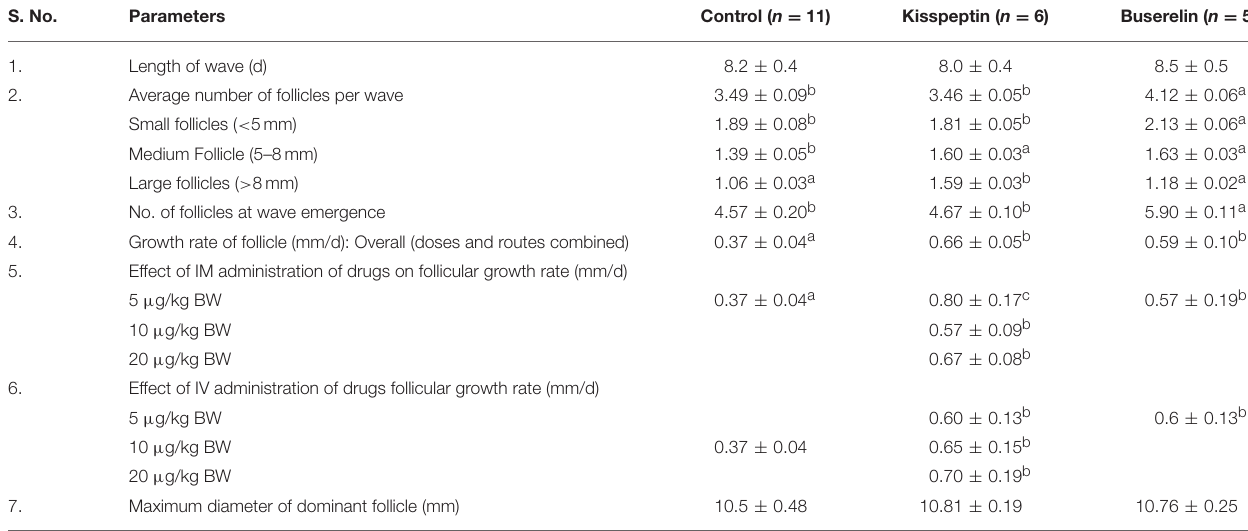
TABLE 1 | Comparison of ovarian response to kisspeptin or buserelin in pre-pubertal buffaloes out of the breeding season. S.